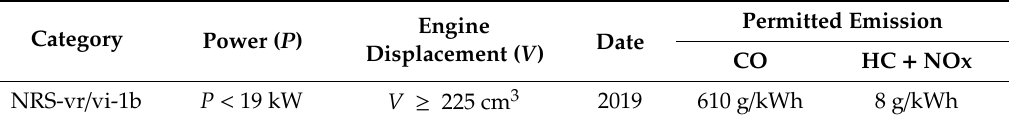
Table 7. Stage V emission standards for non-handheld SI engines below 19 kW (NRS) and engine displacement greater than or equal to 225 cm 3.